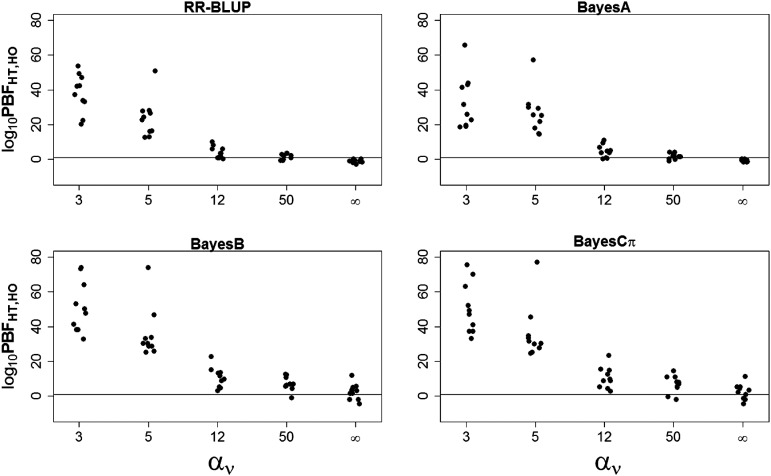
Assessment of global fit, expressed as log10 pseudo-Bayes factor (PBF), between heteroskedastic and homoskedastic whole-genome prediction (WGP) models, namely RR-BLUP, BayesA, BayesB, and BayesCπ, for 10 replicated data sets from each of five simulated scenarios defined by either residual homoskedasticity (αv→ ∞) or a gradient of residual heteroskedasticity ranging from high (αv= 3, 5) to moderate (αv= 12) to low (αv= 50). A horizontal reference line is provided at zero.